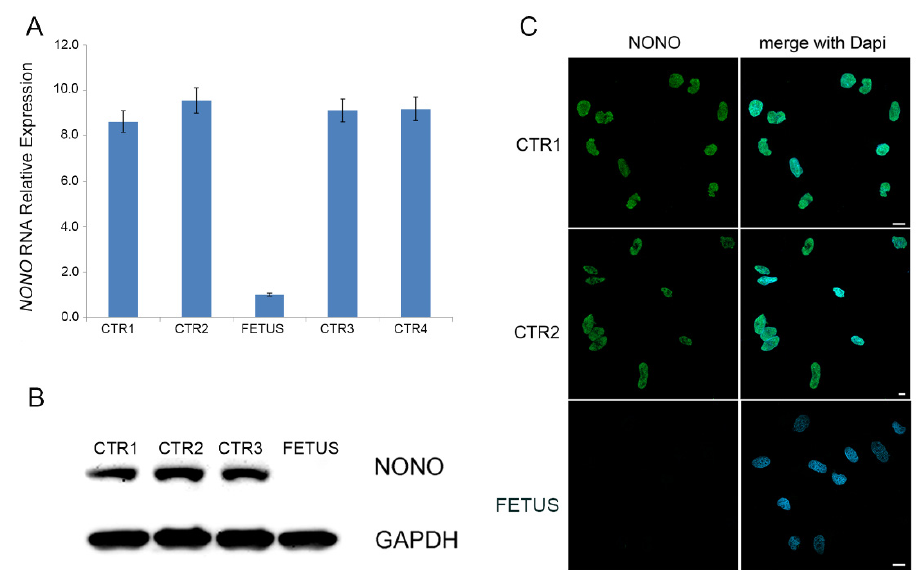
Figure 3. ( A ) Histogram showing about nine-fold decreased expression of NONO in fetal cultured amniocytes compared to four distinct control cells. Data were obtained from two independent experiments. ( B ) The extremely reduction of NONO RNA amount is reflected in the complete absence of the protein on patient cells compare to control cells (CTR), as showed by Western blot (WB) analysis. Representative blot of three independent experiments is shown. Equal amount of cell lysates was resolved by 10% polyacrylamide gel electrophoresis. Membranes were probed with anti- NONO antibody and signals were normalized using GAPDH as internal control. ( C ) Confocal microscopy analysis confirmed absence of the NONO protein in patients’ cells compared to controls’ amniocytes that showed high level of NONO protein and its proper nuclear localization. Scale bar represents 10 µm.